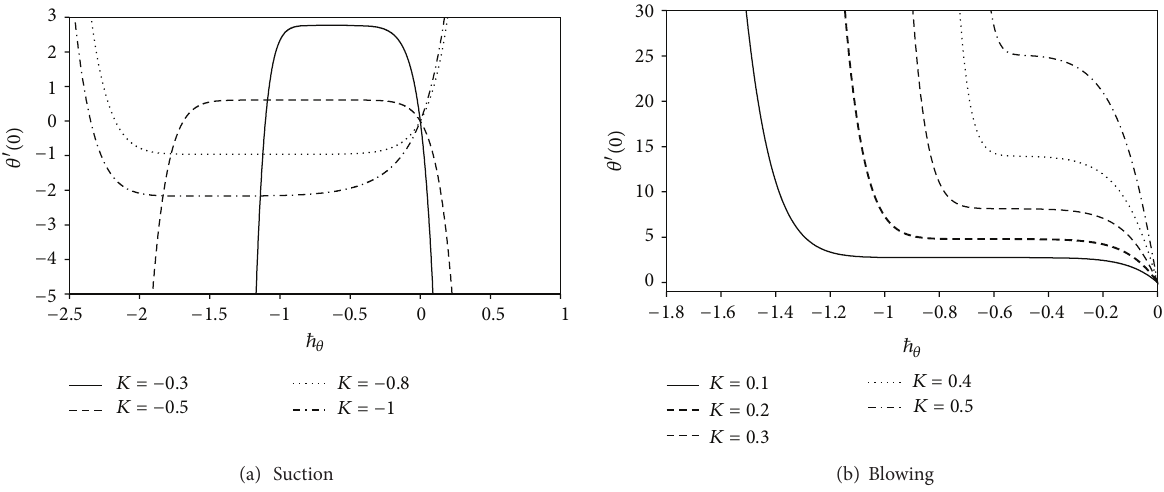
Figure 3: The ℎ 𝜃 curve of 𝜃 󸀠 (0) using 10th-order HAM approximation for the cases 𝑆 = 0.8 , Pr = 1 , and ℎ 𝑓 = −0.8 .